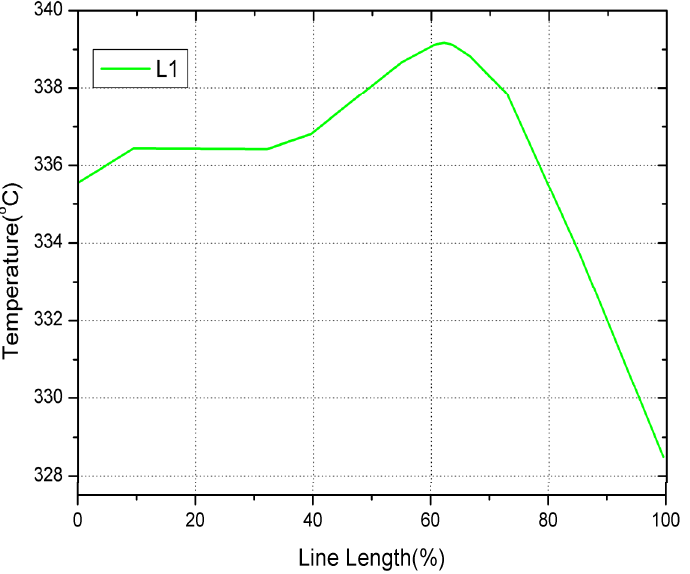
Figure 13. Spatial variation in turbine hosing heat transfer. A comparison of the results of the thermal camera and the thermocouple indicates that the thermal camera error is less than 1 percent, which is acceptable.